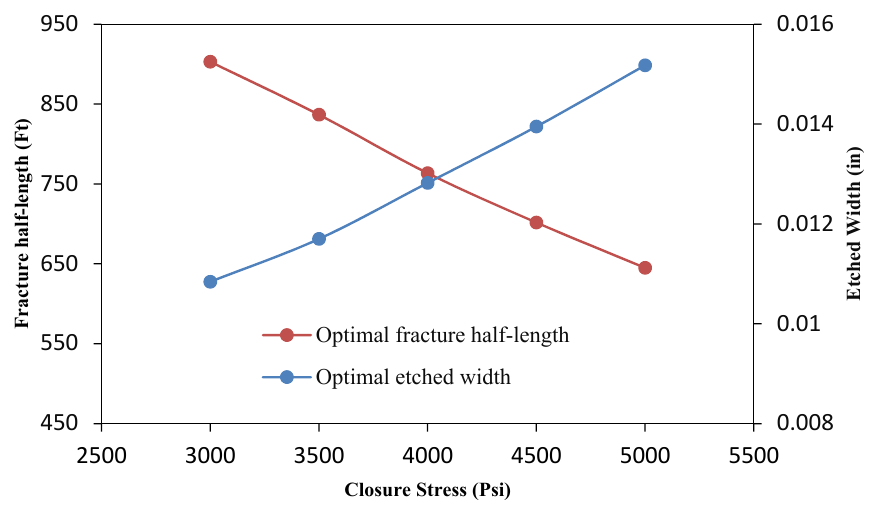
Figure 20. Optimal fracture half-length and etched width vs. closure stress.